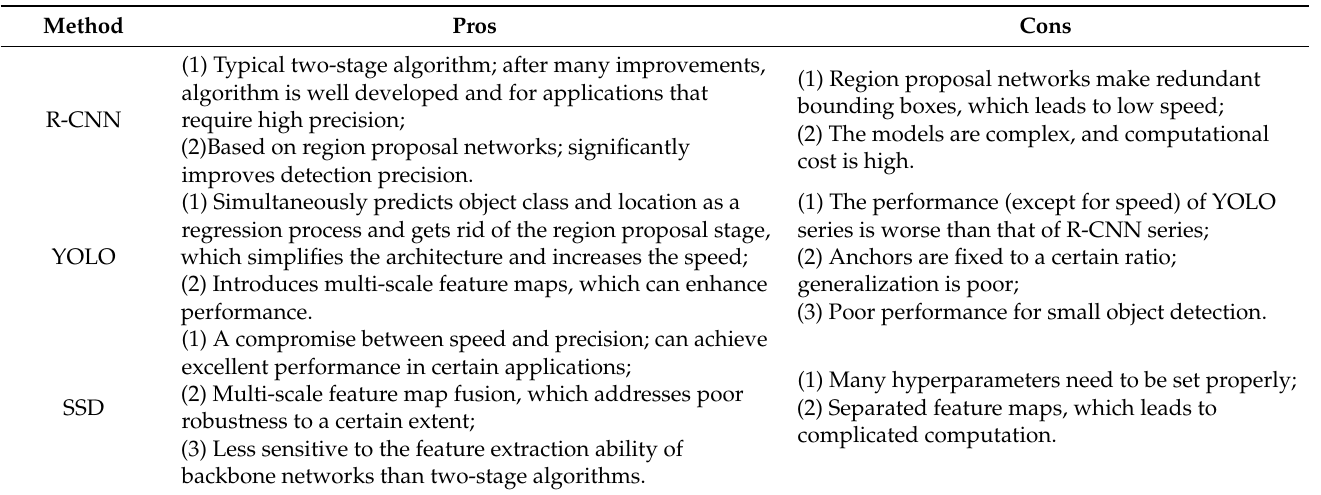
Table 4. Comparison of machine vision methods.